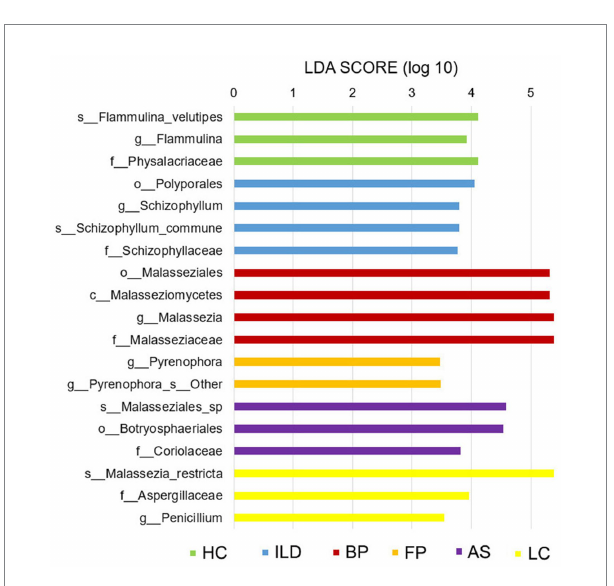
FIGURE 7 Linear discriminant analysis effect size (LefSe) analysis for all six groups. Taxa shown in each group are considered marker taxa distinguishing from all the other groups with significant difference. LDA scores of >3 are presented ( p <